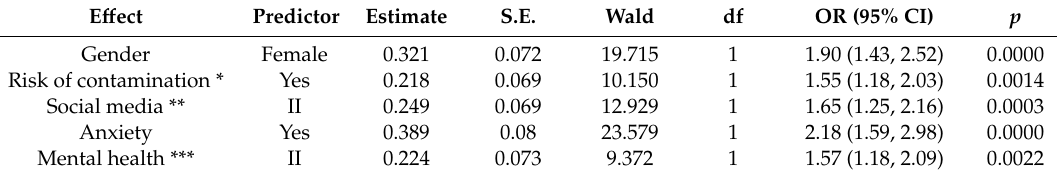
Table 7. Prediction of temporomandibular disorders (TMD) aggravation in Poland.